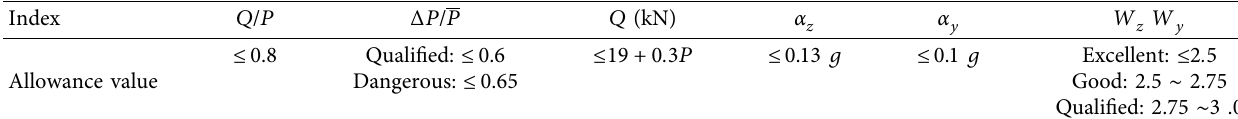
Figure 14: The maximum value of the dynamic response of BEJs in different cases. Table 5: Allowable values of evaluation indexes of the